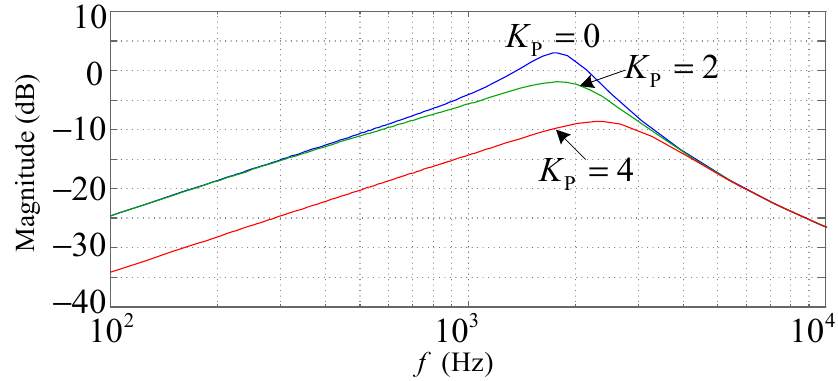
Figure 11. Bode diagram of the compound control system.